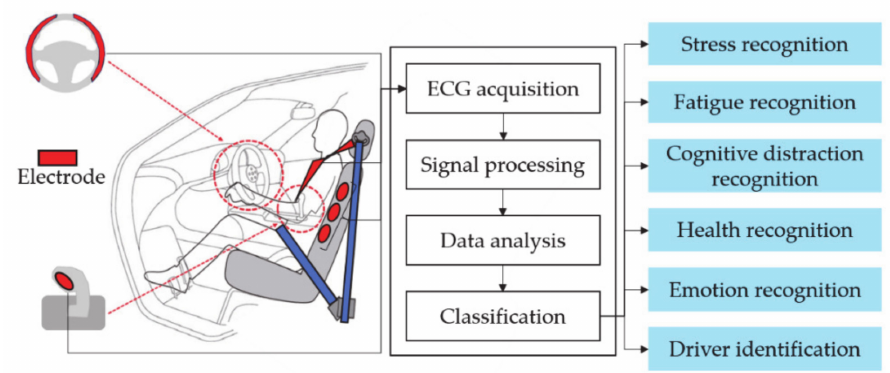
Figure 1. Driver identification and recognition technologies using ECG in vehicle